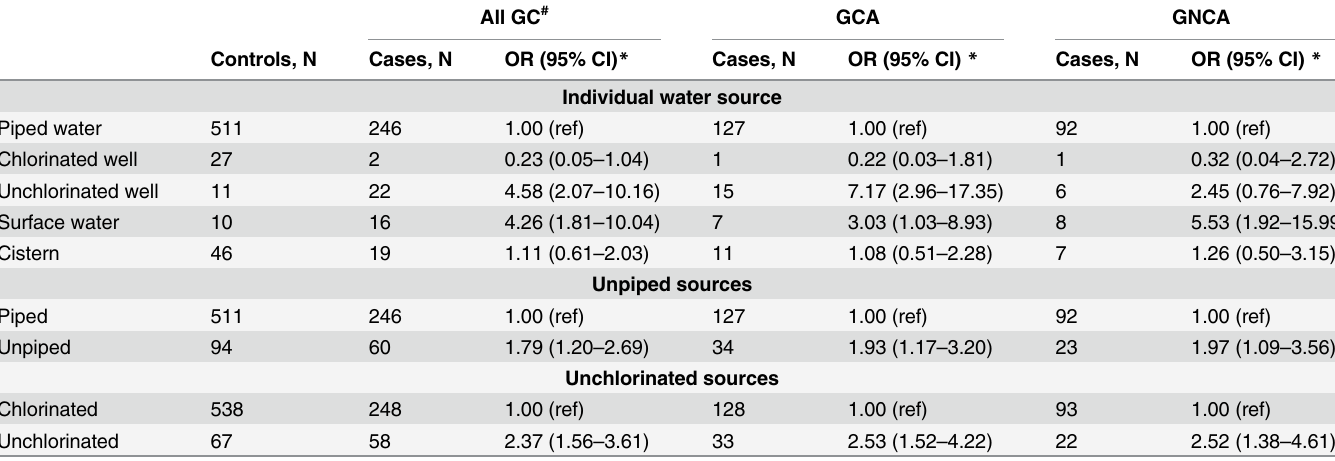
Table 5. Odds Ratios and 95% CIs for GC, GCA, and GNCA by water sources.